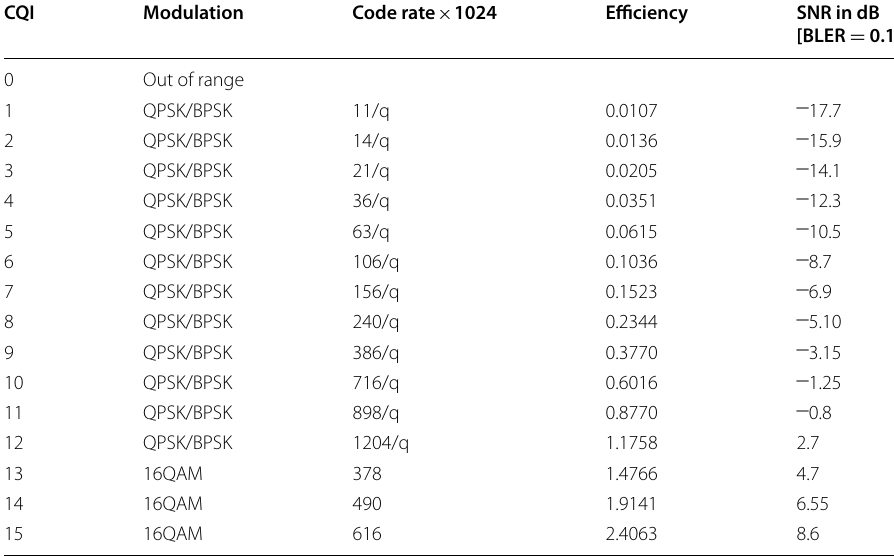
Table 4 Proposed CQI table for coverage enhancements